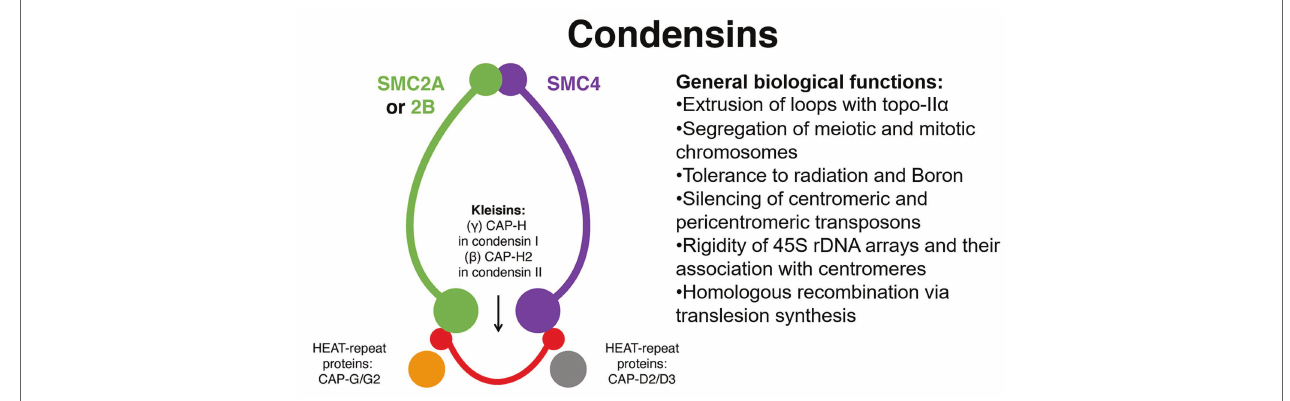
FIGURE 5 | Simplified functional network for SMC condensin complexes during genome maintenance and organization. The plant condensin complexes are versatile and regulate a wide range of processes including chromatin loop extrusion, chromosome segregation, silencing of centromeric transposable elements, organization of 45S ribosomal DNA arrays, and homologous recombination that affect pollen and embryo development. Much of this activity is facilitated by HEAT- repeat proteins CAP-G/G2 and CAP-D2/D3. Topo-II α , topoisomerase-II α